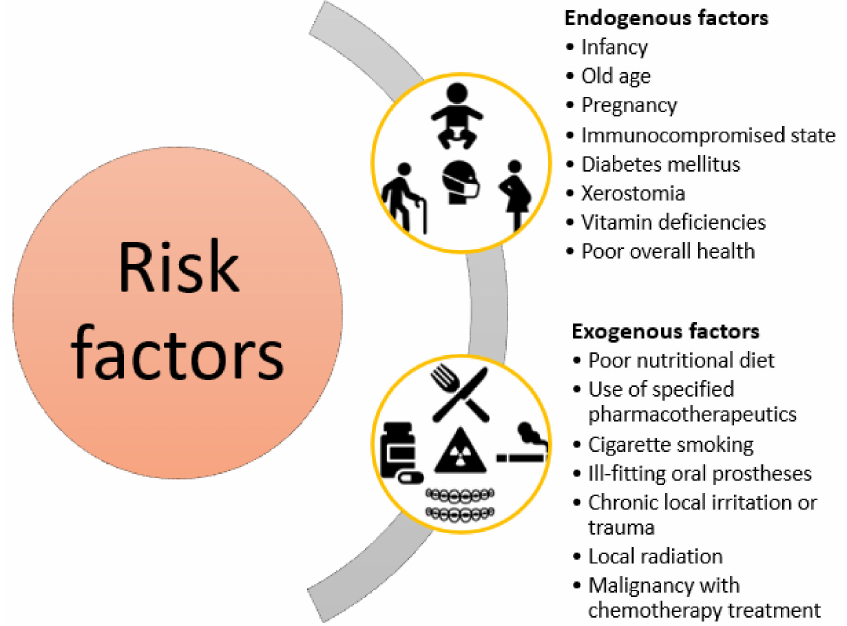
Figure 1. Classification of risk factors associated with oral candidiasis development. Created based on information from literature references